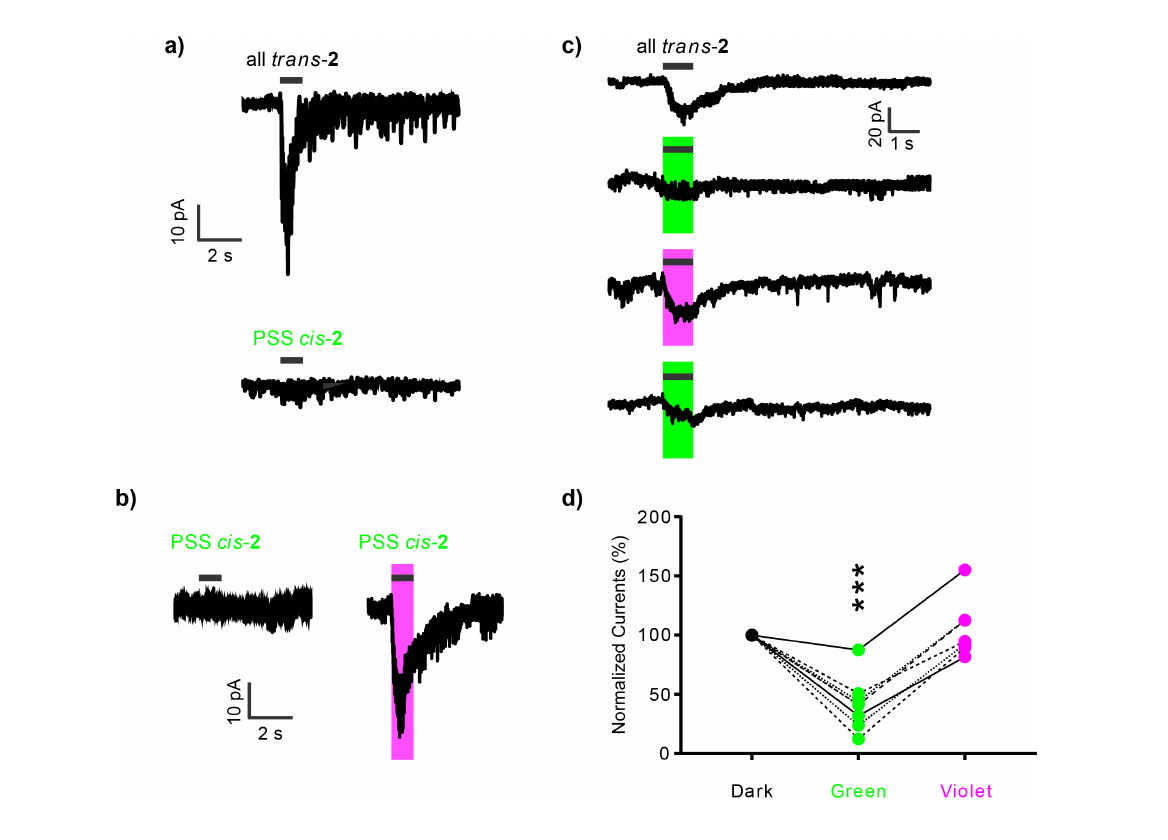
Figure 5: Photopharmacology with 4FABTA ( 2 ). Currents from neurons in the medial habenula in acutely isolated brain slices were measured using the whole-cell patch-clamp method. Signals from nicotinic acetylcholine receptors were isolated by blocking voltage-dependent Na + channels, muscarinic, GABAergic, and glutamatergic receptors. Photochrome 2 was puffed locally for 1 s (0.2 mM, black bar). LEDs centered at 405 and 530 nm were used for photoswitching. a) Representative responses evoked by all trans - 2 and cis- 2 in the green PSS. b) Representative responses evoked by cis - 2 in the green PSS without and with violet light (10 mW). c) Sequential responses from the same neuron when all trans - 2 was applied without irradiation (top) or with either green or violet light. The interval between sweeps was 3 min. d) Summary of the responses in the first three sweeps (dark-green-violet) from experiments shown in (c). The amplitudes of currents were normalized to the 1st dark response for each cell, n = 7 cells, *** indicates P < 0.001 in paired